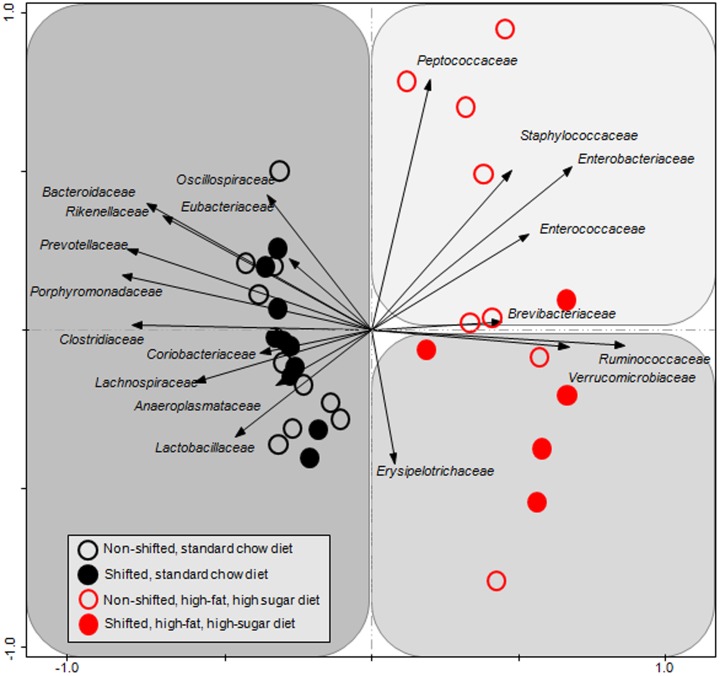
Family-level gut microbial community analysis.The composition of bacterial communities from each sample, grouped at the family level, was analyzed using principal component analysis of log-transformed and standardized data, as described in the text. Vectors, or arrows, point in the direction of the steepest increase of values for the corresponding family. The angle between arrows indicates approximated correlation (>90° indicates negative correlation). The samples are indicated with individual symbols, according to treatment, and the distance between symbols approximates the dissimilarity of their microbial communities, as measured by Euclidean distance. PCA axes 1 and 2 explain 47.51% of the variation.